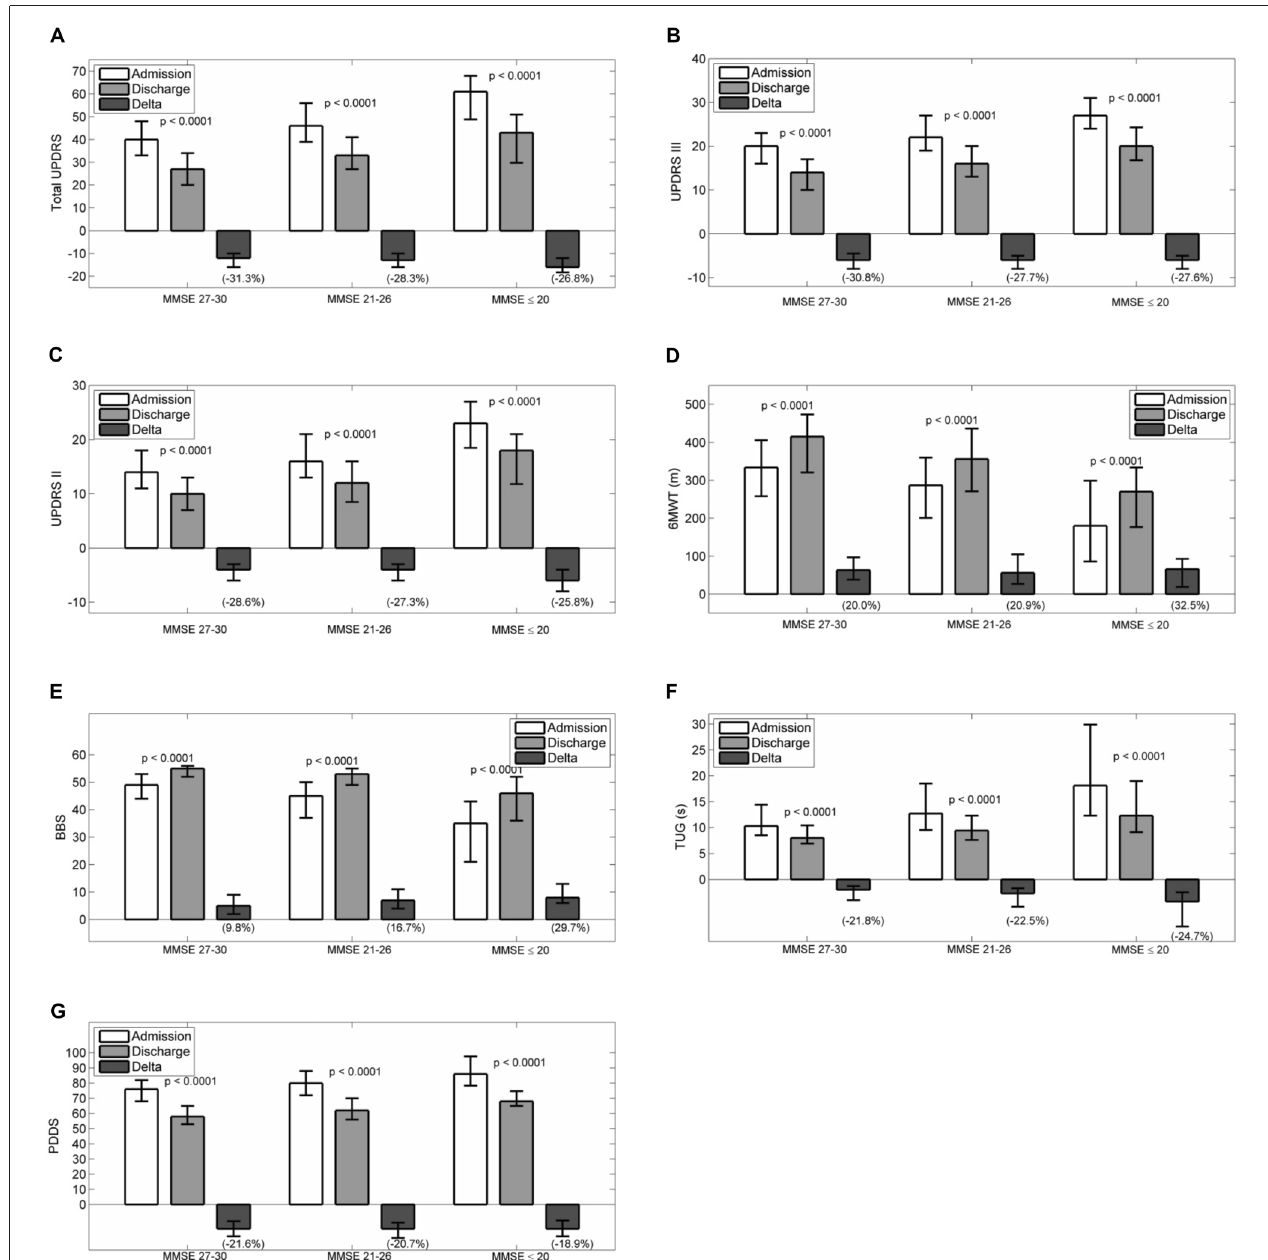
FIGURE 1 | Admission, discharge and delta (discharge-admission) for all the outcome variables in patients grouped according to MMSE: (A) Total UPDRS, (B) UPDRS III, (C) UPDRS II, (D) 6MWT, (E) BBS, (F) TUG, (G) PDDS. Data are reported as median (box), lower and upper quartile (whiskers). The percentage value of delta is reported in brackets. The p values are pertaining to the comparison discharge vs. admission. Abbreviations: MMSE, Mini Mental State Examination; UPDRS, Unified Parkinson’s Disease Rating Scale; 6MWT, Six Minutes Walking Test; BBS, Berg Balance Scale; TUG, Timed Up and Go Test; PDDS, Parkinson’s Disease Disability Scale